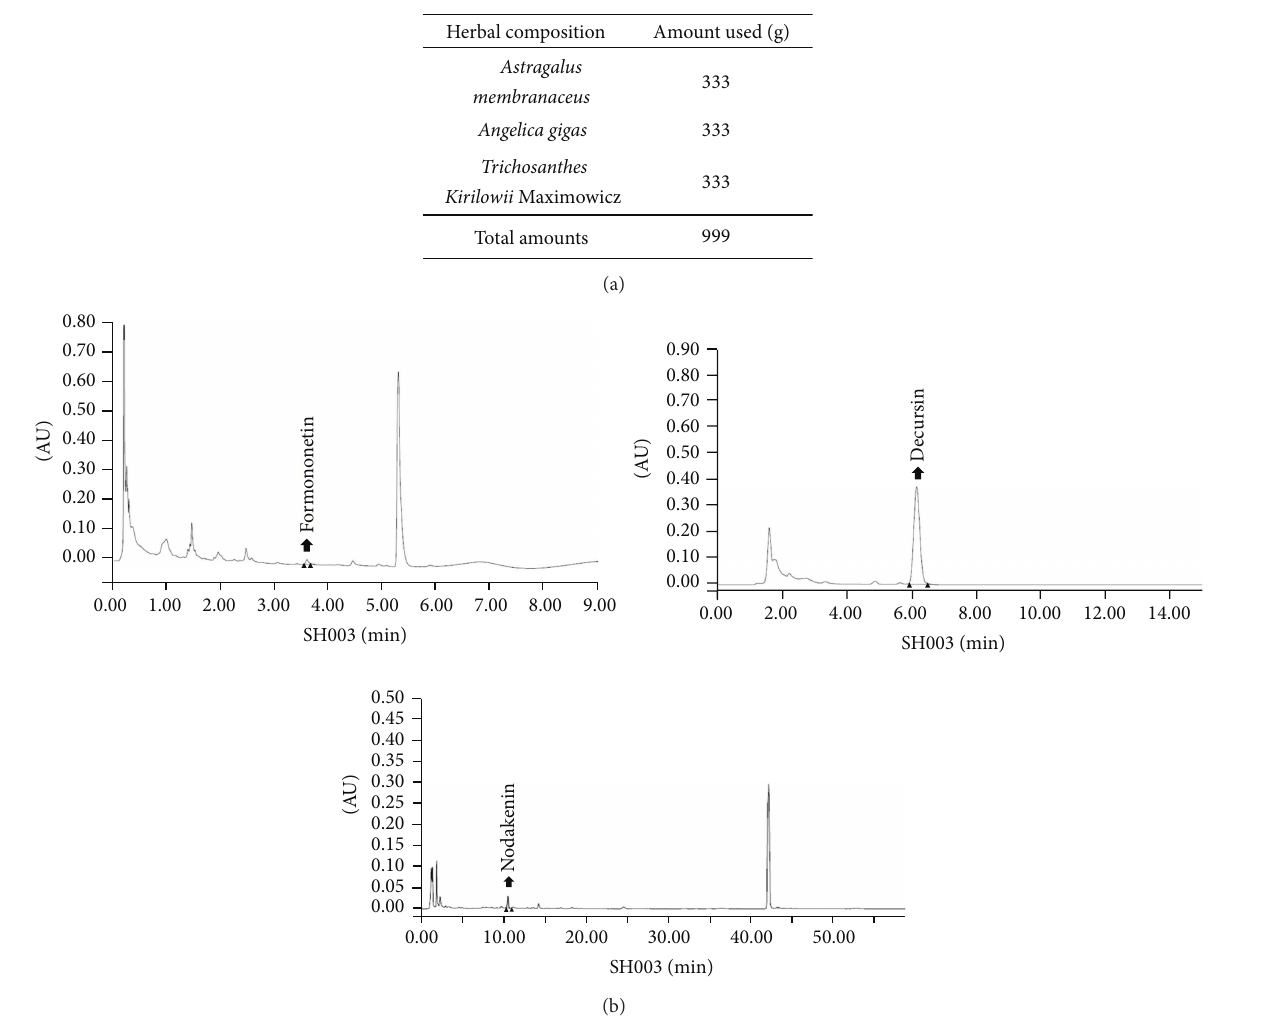
Figure 1: HPLC profile of SH003. (a) Composition of SH003. (b) HPLC identification of components in SH003. Formononetin, decursin, and nodakenin were detected in Am and Ag. Three components in SH003 were detected at 3.6 min, 6.1 min, and 11.0min.